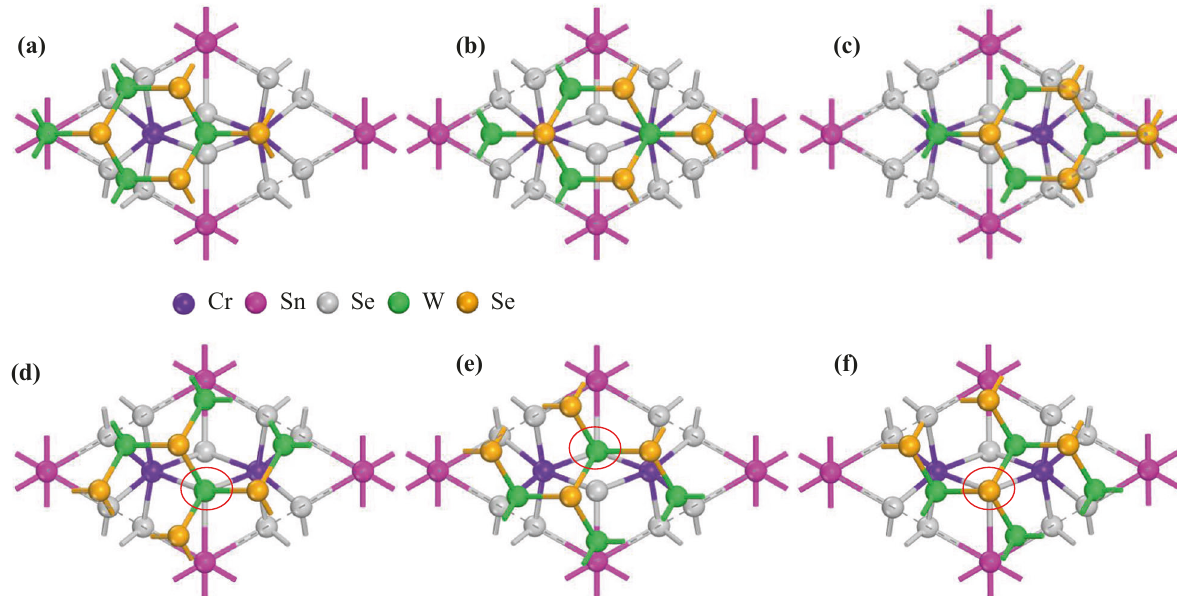
Fig. 2 Six possible con fi gurations of WSe 2 /CrSnSe 3 heterostructure. Schematic illustration of six possible stacking con fi gurations of WSe 2 / CrSnSe 3 heterostructure; a S-1, b S-2, c S-3, d S-4, e S-5, and f